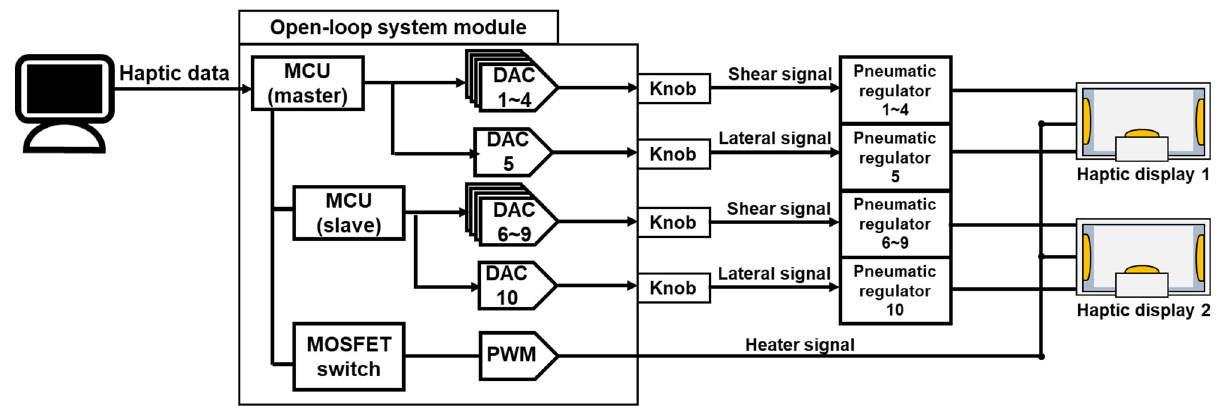
Figure 5. Functional diagram of the custom-designed control module.